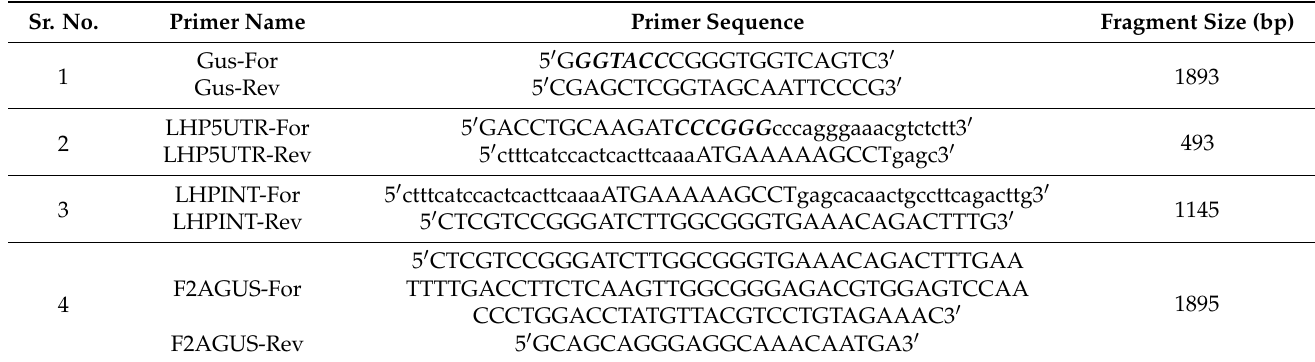
Table 1. List of primers used in this